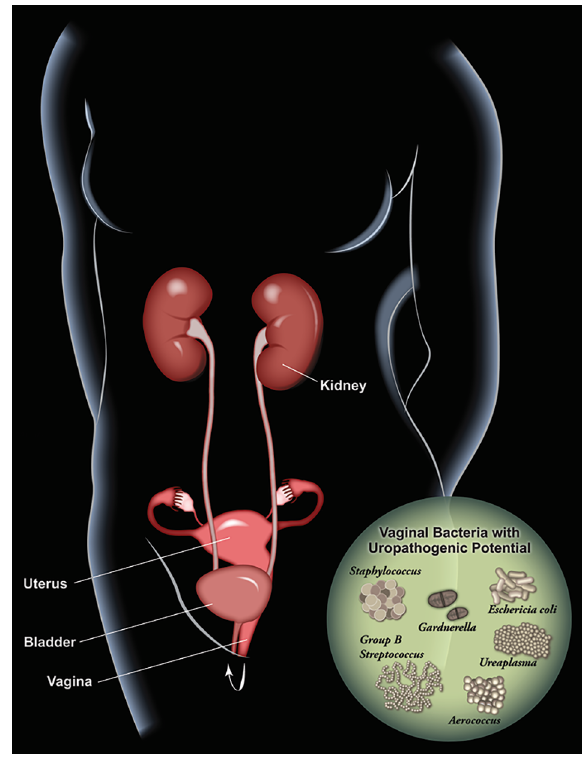
Figure 2: Schematic illustrating vaginal bacteria with potential to impact the urinary